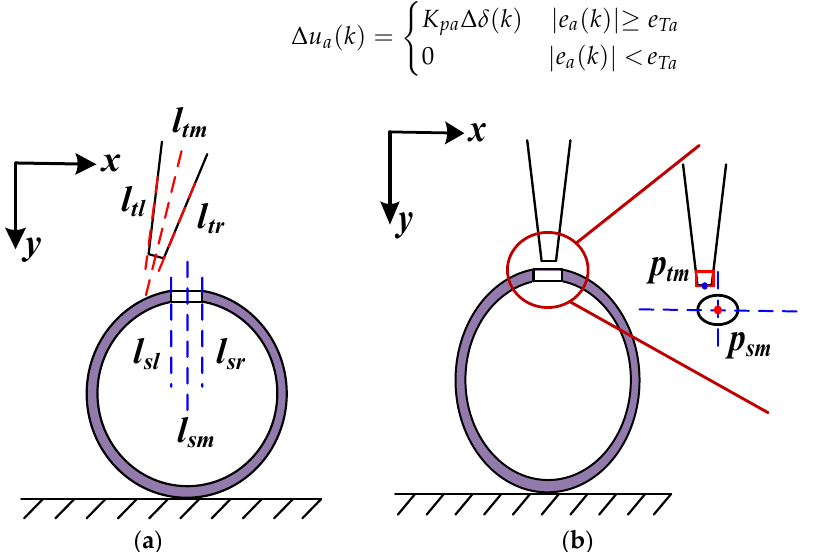
Figure 4. Image feature extraction to calculate attitude and position error: ( a ) feature to calculate attitude error; ( b ) feature to calculate position error.